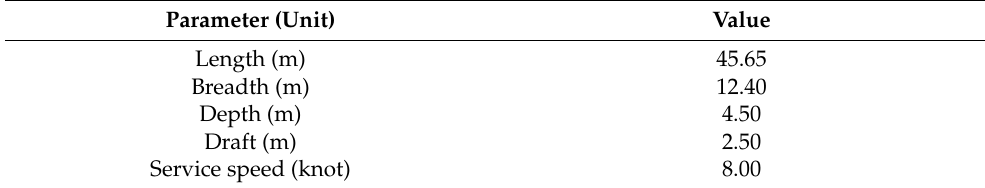
Table 2. Principal dimensions and specifications for the LNG bunkering